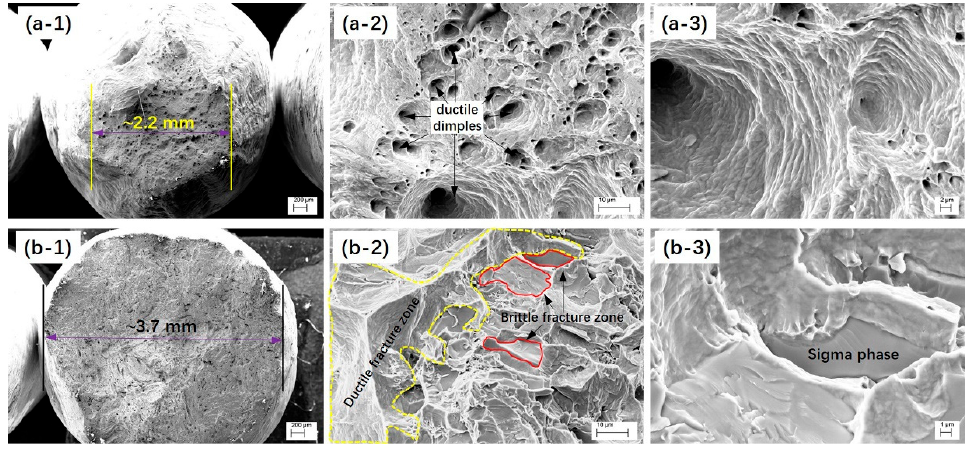
Figure 11. Tensile fracture surfaces of Z3CN20.09M specimens unaged ( a ) and aged at 750 °C for 200 h ( b ); 1 —low magnification, 2 —moderate magnification, and 3 —high magnification.